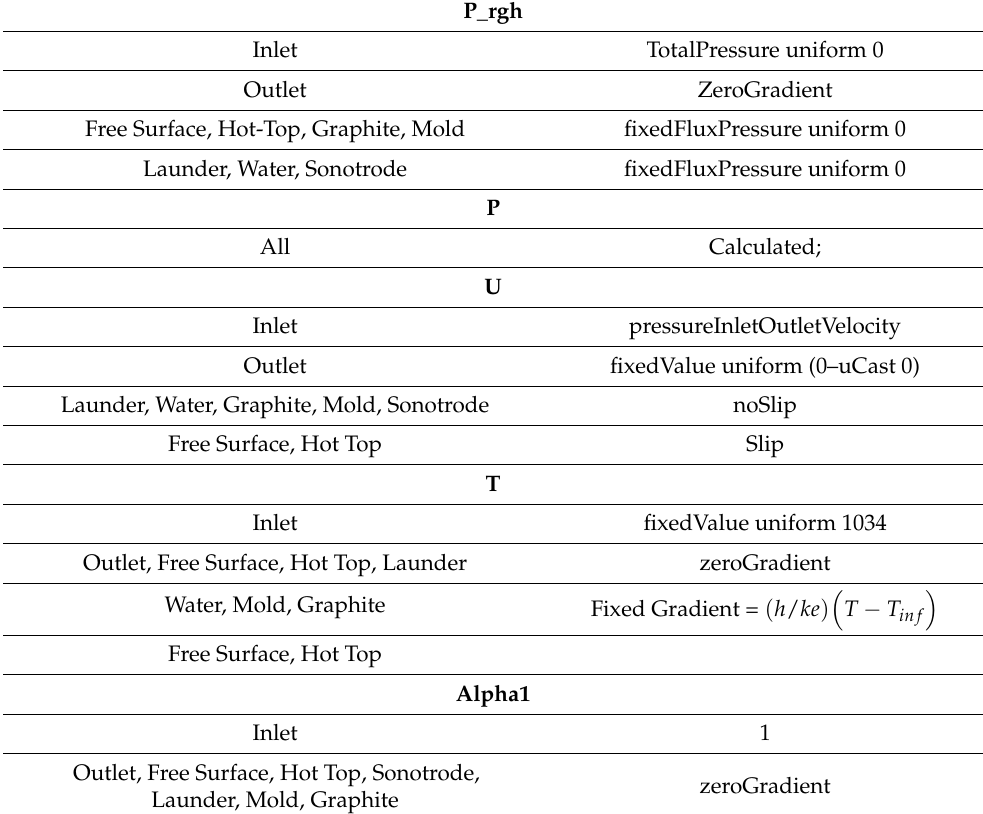
Table 4. Fluid flow model boundary